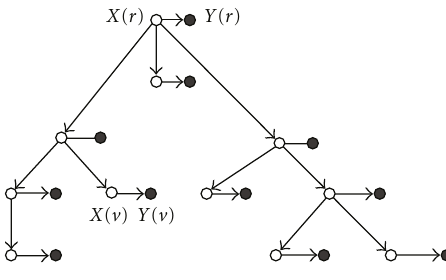
Figure 6: Structure of hidden Markov tree